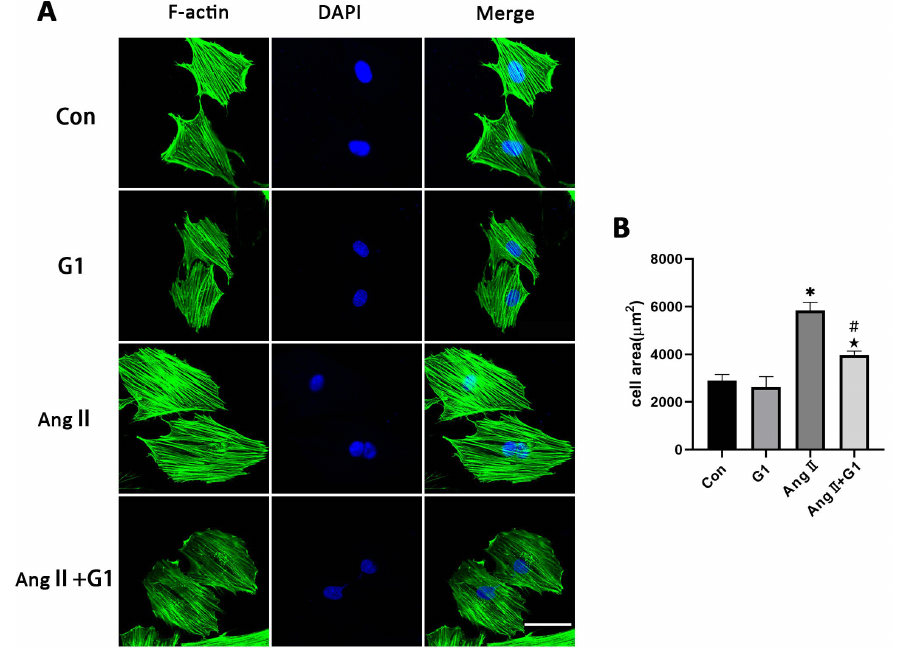
Figure 6. G1 attenuated AngII-induced hypertrophy of H9c2 cells in vitro. ( A ) Representative confocal microscopy images of the H9C2 cells by Phalloidin Staining (scale bar = 50 µm). ( B ) cell area of H9c2s from different groups. The data is expressed as mean ± SEM and was analyzed by one-way ANOVA (n = 4). * p < 0.05 vs. CON; # p < 0.05 vs. G1; (cid:70) p < 0.05 vs. AngII.